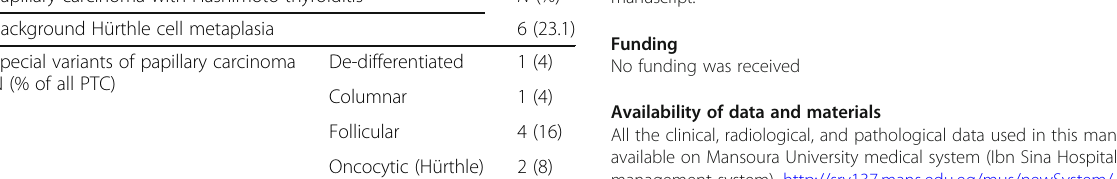
Table 2 Additional observations in cancer with Hashimoto thyroiditis Papillary carcinoma with Hashimoto thyroiditis N (%) Background Hürthle cell